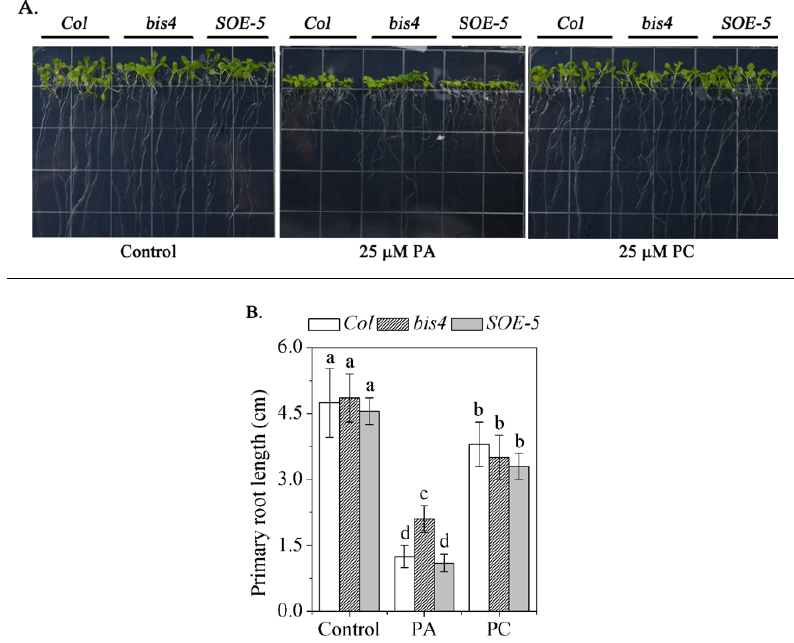
Figure 5. Primary root growth phenotype of Col , bis4, and SOE-5 plants. ( A ) Seeds were germinated on MS media for 3 d, after which they were transferred to 25 µM phosphatidylcholine (PC) or phosphatidic acid (PA). ( B ) The length of the primary roots of each genotype plant was averaged after 6 d of vertical growth. Bars with different letters indicate that the value was significantly different ( P < 0.05).